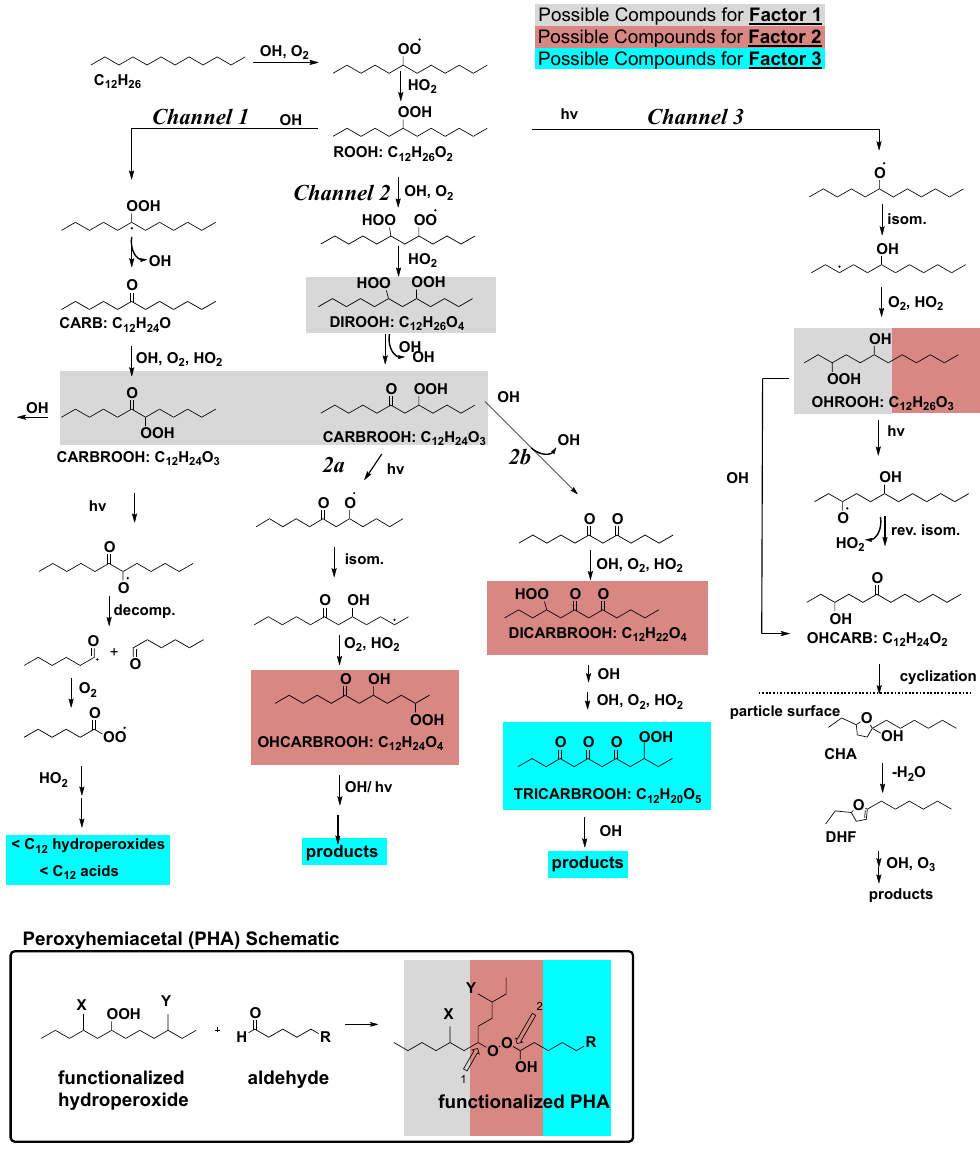
Fig. 2. Simplified chemical mechanism for dodecane photooxidation under low-NO x , adapted from Yee et al. (2012). Shaded portions of the mechanisms are possible assignments for the PMF factors 1, 2 and 3, as discussed in Sects. 3.4 and